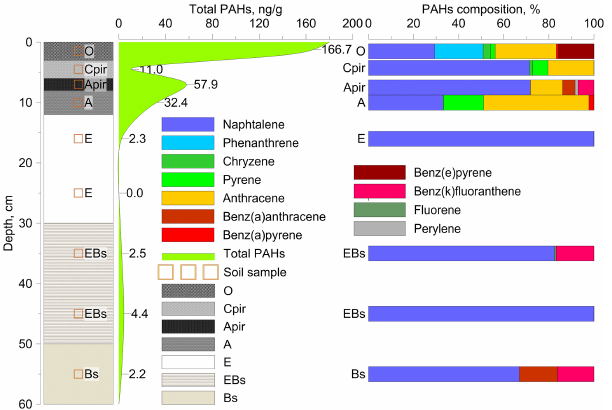
Figure 10. The profile distribution and PAH composition in post- pyrogenic histic podzols from the wildfire of 2002 (pit 5). Hpir horizons, for benz(a)pyrene (283 %), benz(ghi)perylene (283 %), benz(k)fluorantene (437 %), and chrysene (195 %). The variation of low-molecular-weight compounds was lower; in H horizons, coefficients of variation for naphtha- lene were 131 and 126 % for phenanthrene.